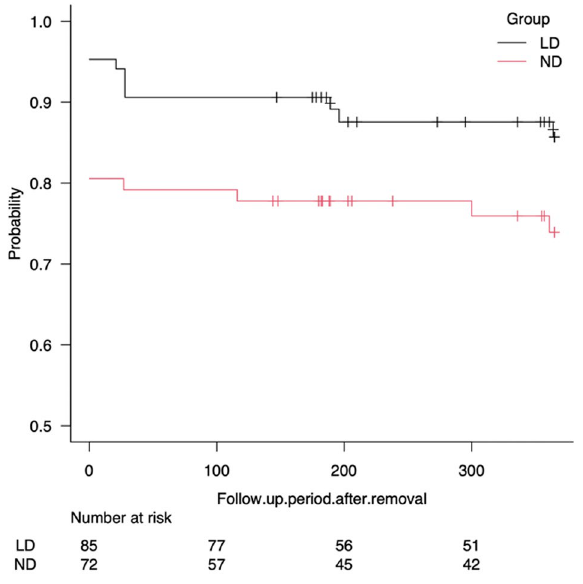
Figure 4. Kaplan–Meier curve of lacrimal duct patency at 1 year after tube removal. The Kaplan–Meier curve indicates that the lacrimal duct patency rate was 85.7% (95% CI; 75.4, 91.9) in the LD group and 73.9% (95% CI; 61.7, 82.8) in the ND group at 1 year after the tube removal. There were 11 recurrences and 23 censored cases in the LD group and 18 recurrences and 14 censorings in the ND group. The y -axis denotes the patency rate, and the x -axis indicates the number of days.